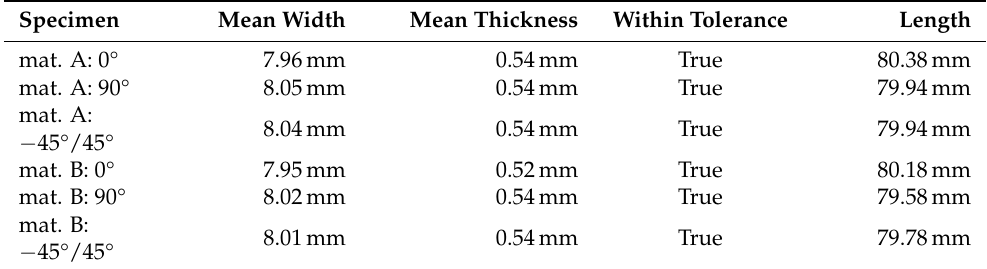
Table 12. Measured dimensional accuracy of the 3D printed specimens using a digital calliper. Specimen Mean Width Mean Thickness Within